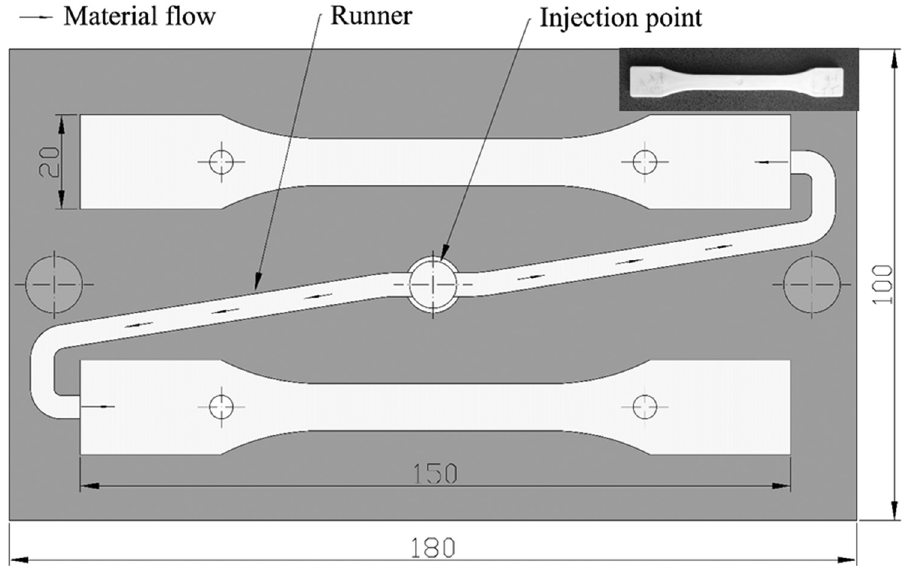
Figure 1: Top view schematic of the injection mold, with an injection angle of 0°. The arrows show the melted material fl ow; indicated sizes are in mm ( adapted from ( 18 ))